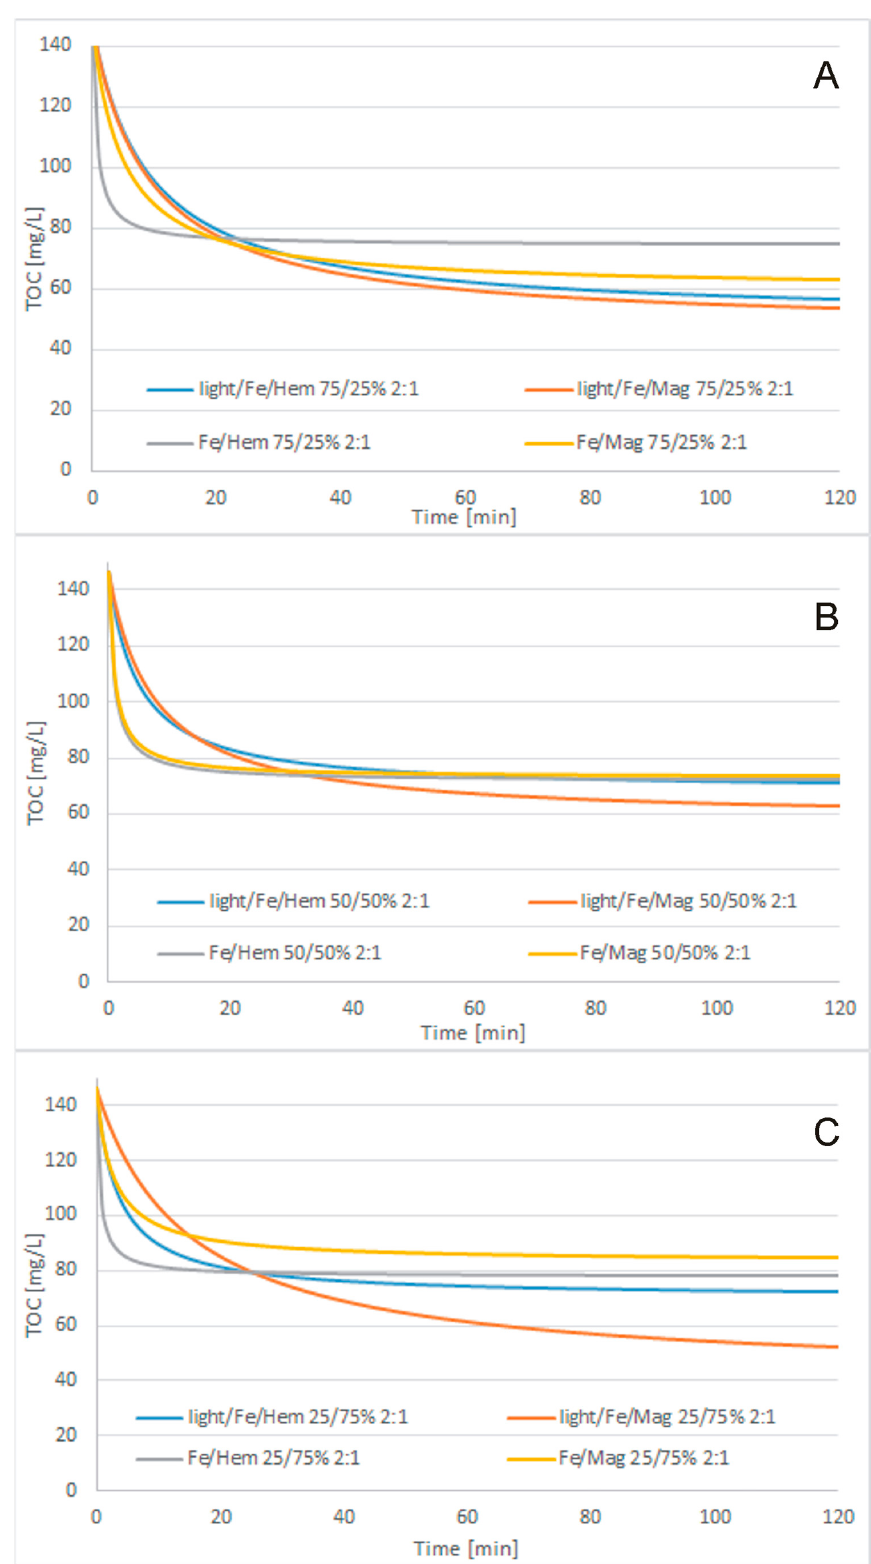
Figure 4. Cosmetic wastewater treatment, modified 2nd-order kinetic model matching results, 2:1 H 2 O 2 /COD ratio, catalyst ratio: ( A ) 75/25 Fe/Iron oxide, ( B ) 50/50 Fe/Iron oxide, ( C ) 25/75 Fe/Iron oxide.